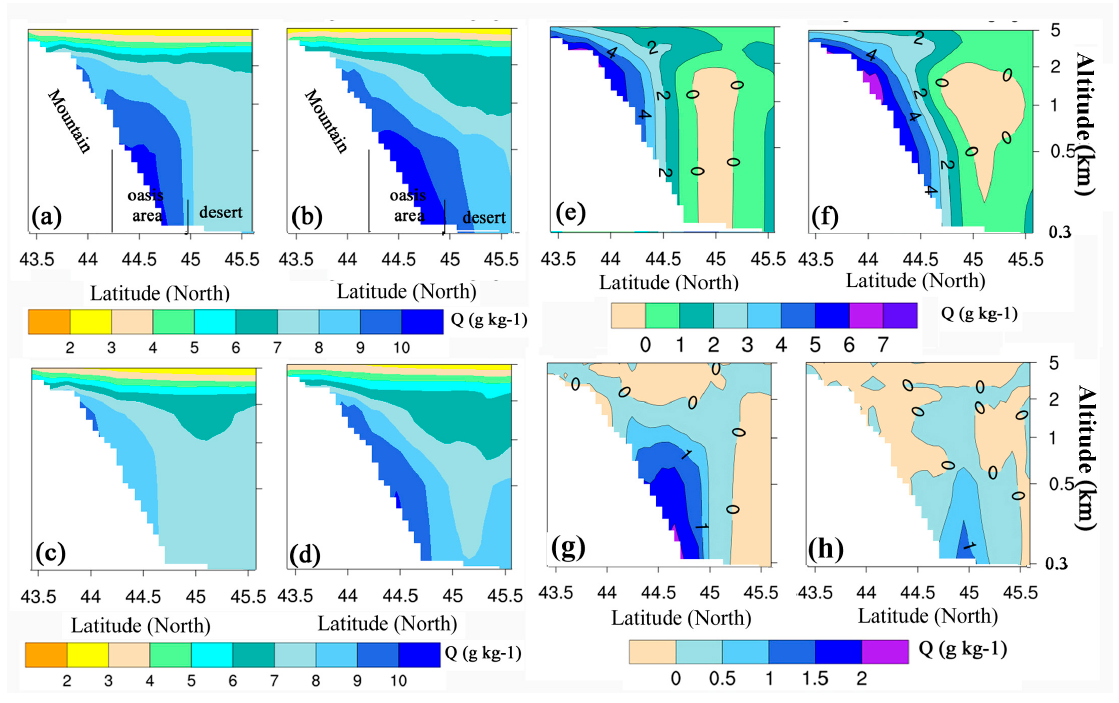
Figure 9. Same as Figure 6 but for the vertical section of specific humidity Q (g kg − 1 ) along the white line (longitude 85.7° E) shown in Figure 6a.